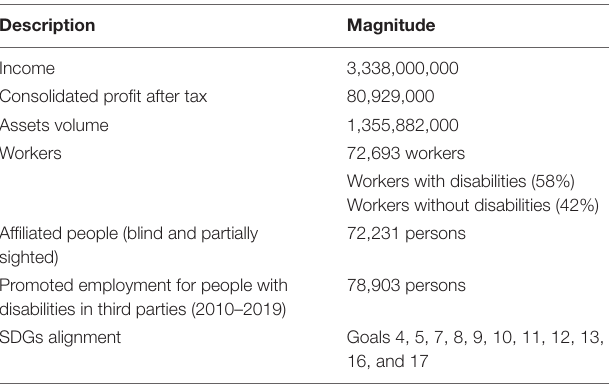
TABLE 1 | Detailed information on the ONCE Social Group.